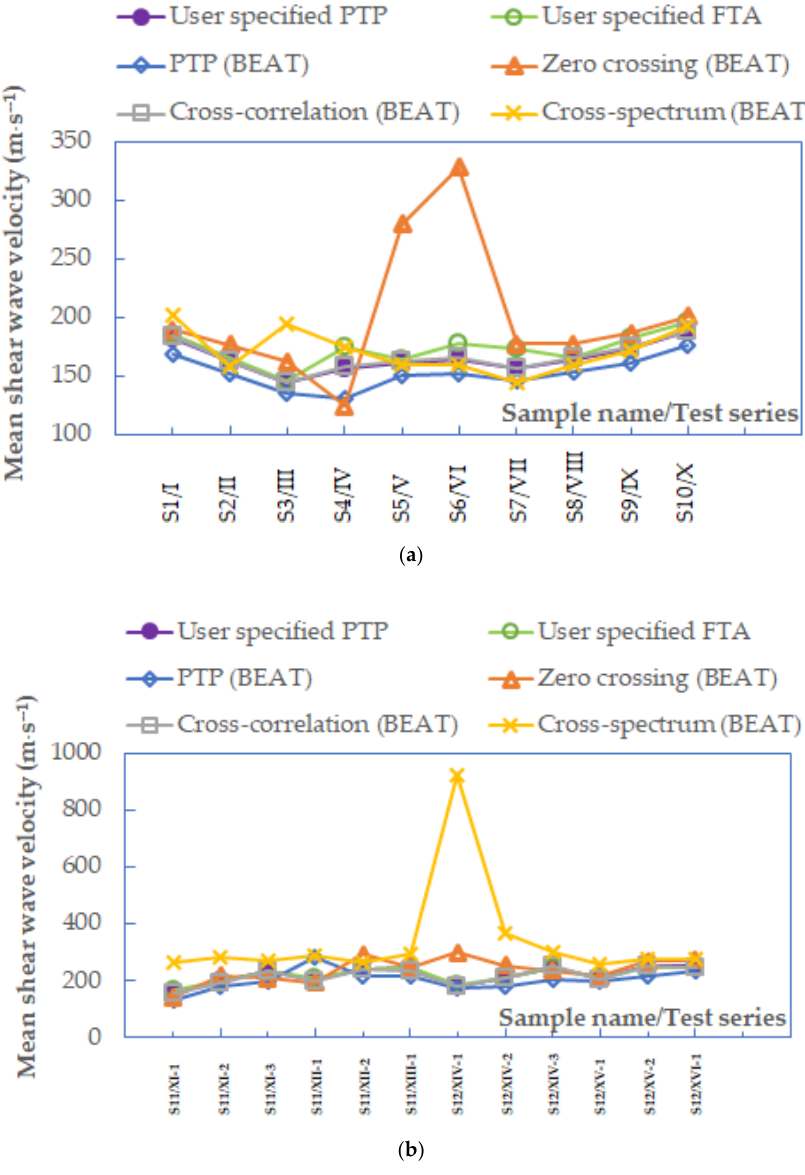
Figure 11. Summary of mean values of shear wave velocities from different interpretation methods when f < 3.3 kHz, data for specimens ( a ) S1–S10 and ( b )